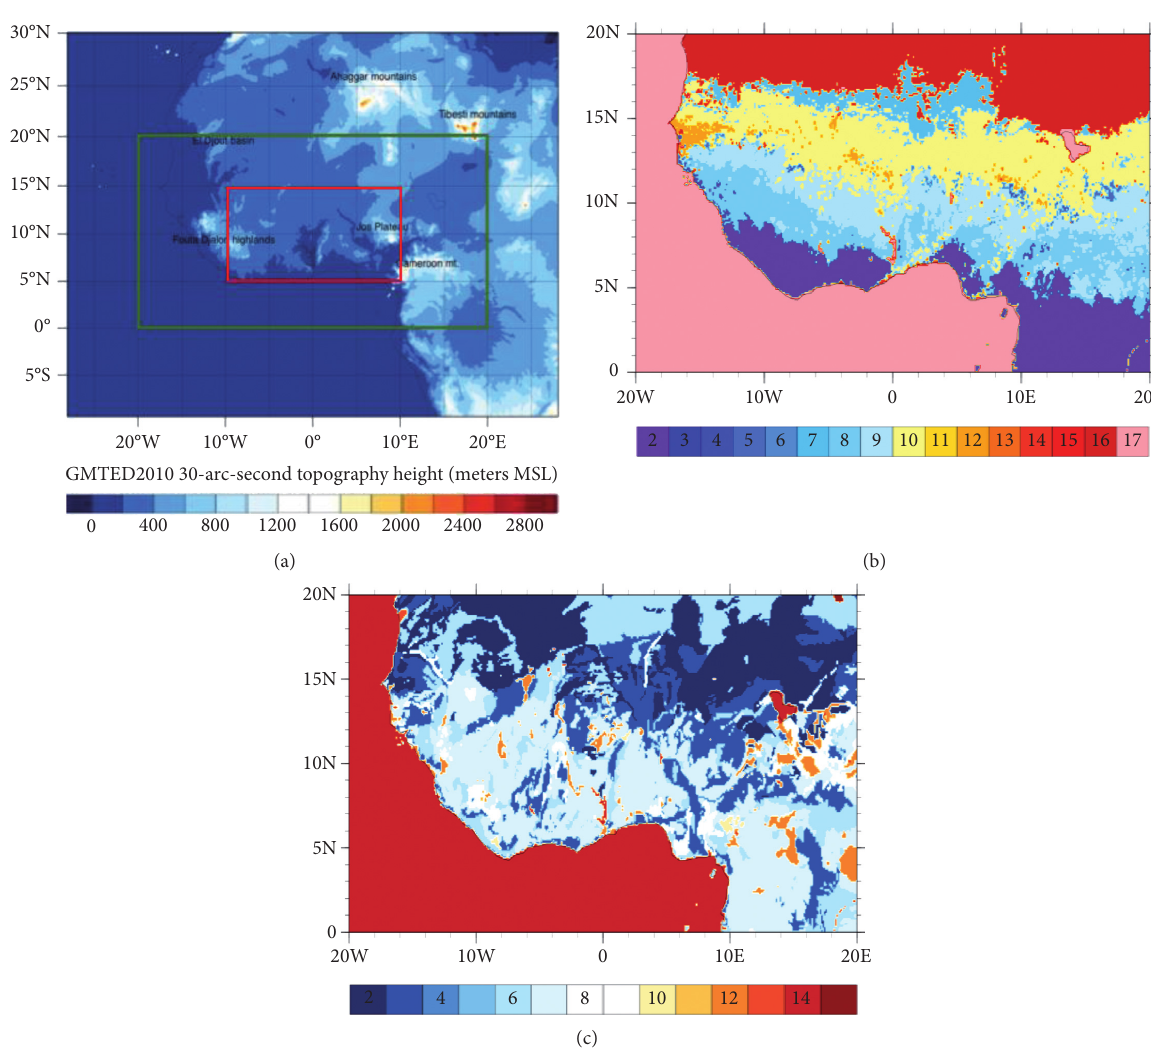
Figure 1: (a) Map showing the model domain with the elevation map of West Africa. The red box (5 ° N–15 ° N and 10 ° E–10 ° W) is the domain for area average of the parameters while the green box is the evaluation area for the spatial plots; (b) land use category map of the study area (2. evergreen broadleaf forest; 3. deciduous needleleaf forest; 4. deciduous broadleaf forest; 5. mixed forests; 6. closed shrublands; 7. open shrublands; 8. woody savannas; 9. savannas; 10. grasslands; 11. permanent wetlands; 12. croplands; 13. urban and built-up; 14. cropland/ natural vegetation mosaic; 15. snow and ice; 16. barren or sparsely vegetated; 17. water); (c) soil type category map of the study area (2. loamy sand; 3. sandy loam; 4. silt loam; 5. silt; 6. loam; 7. sandy clay loam; 8. silty clay loam; 9. clay loam; 10. sandy clay; 11. silty clay; 12. clay 13. organic material; 14. Water; 15.